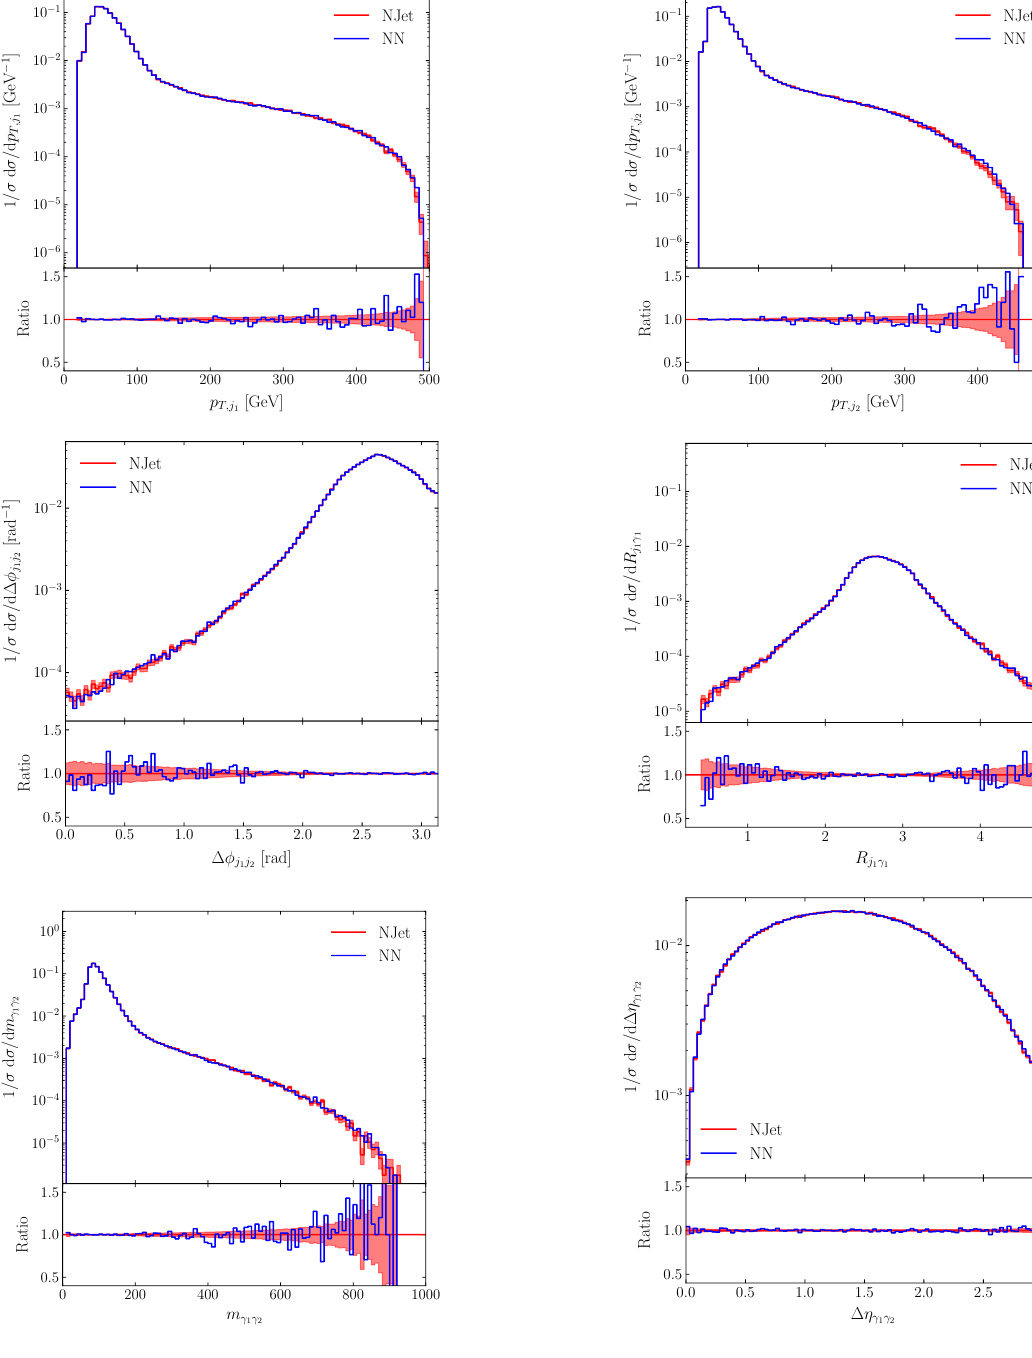
Figure 3. Differential distributions normalised to the cross section for the 2 → 3 process comparing NJet (red) with the NN ensemble (blue). The NJet results are quoted with MC errors, and the NN results with precision/optimality uncertainties calculated as described in ref. [60] but which are negligible in comparison. Pseudojets j i and photons γ i are ordered by energy, ∆ φ is azimuthal separation, R -separation is defined in section 3.2.1, and m γ pseudorapidity separation of the diphoton